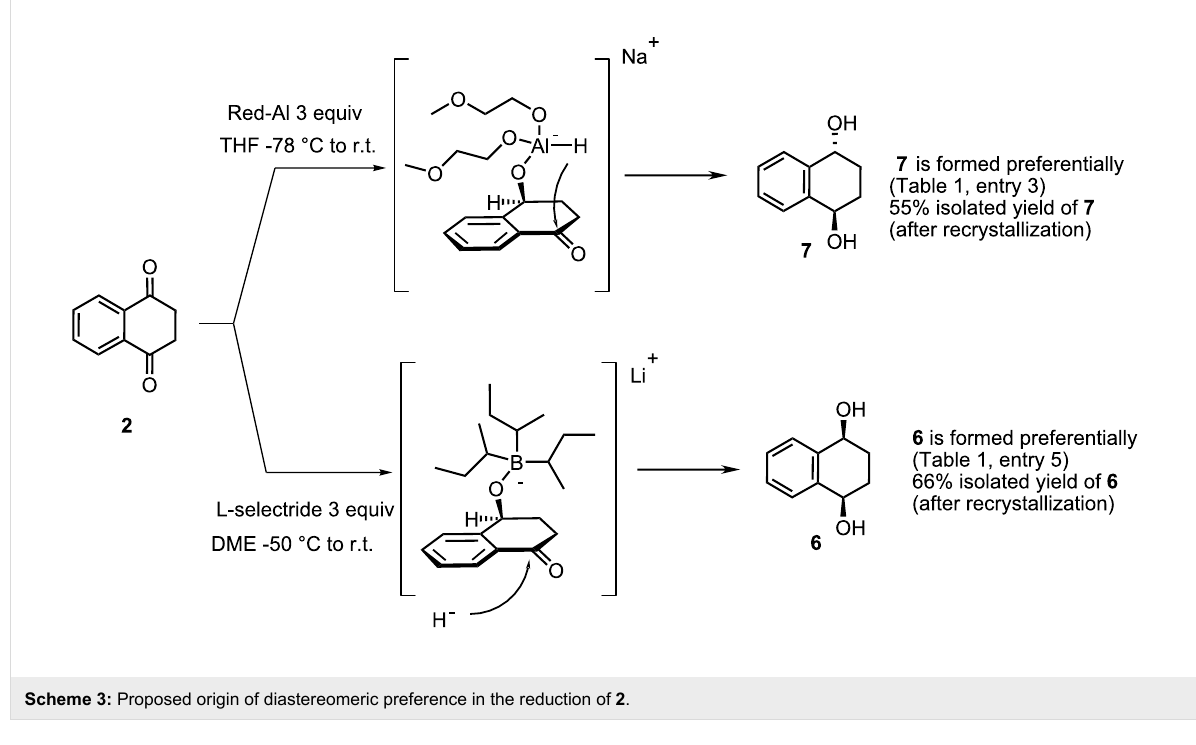
mixture of the corresponding cis and trans -dibromides, which were converted into diacetates with AgOAc (81% yield).